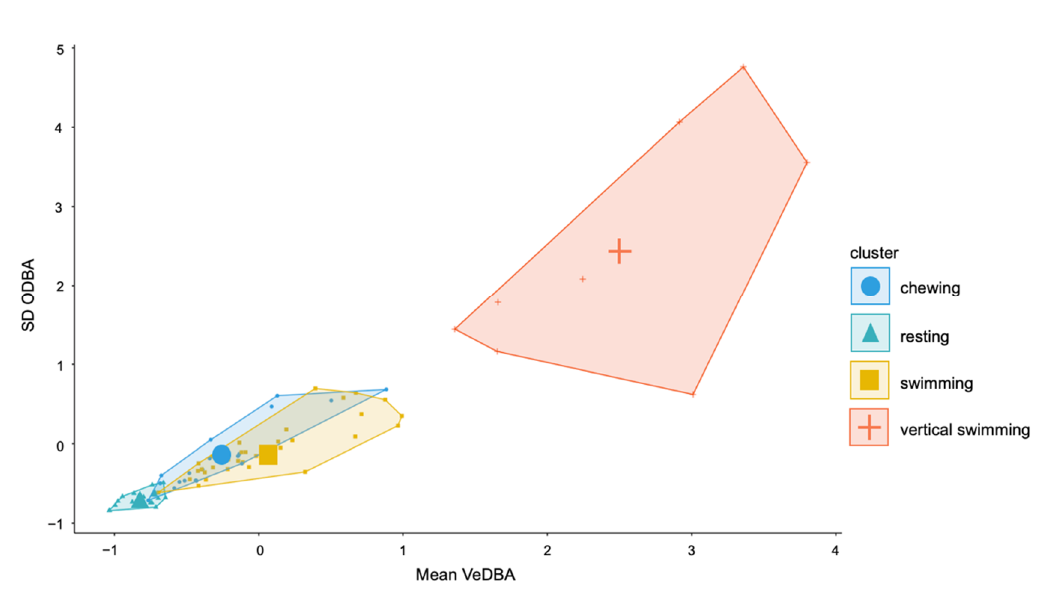
Figure 6. Cluster plot of SD ODBA and mean vectorial dynamic body acceleration (VeDBA) for the 2 s epoch for four behaviours.